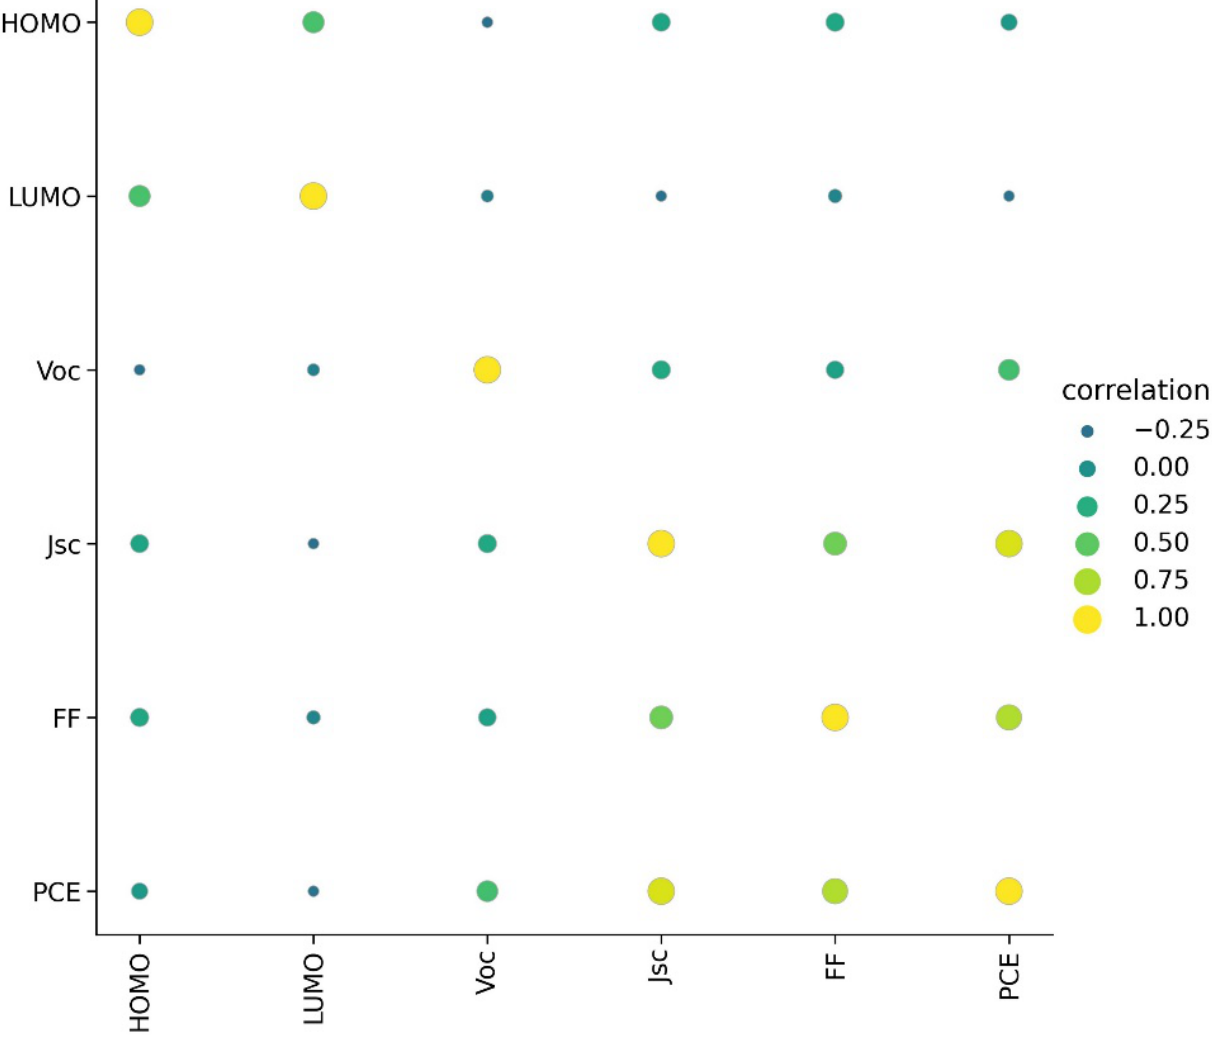
Figure 1. Correlation between parameters in dataset.